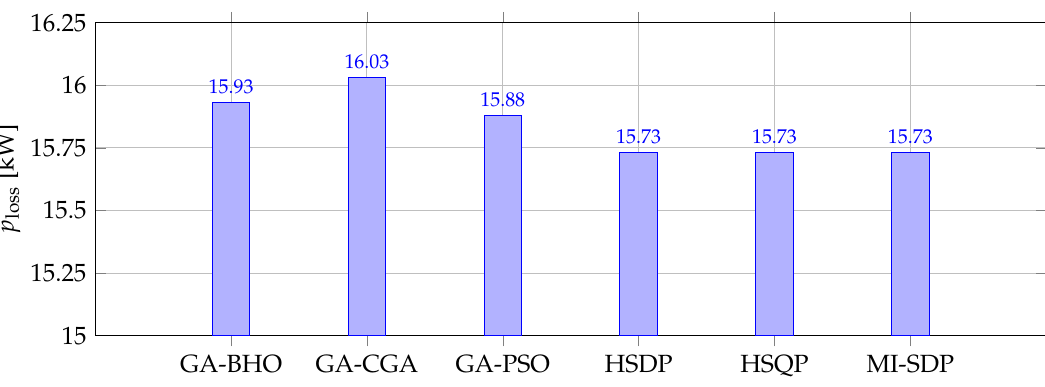
Figure 8. Final power losses when heuristics and metaheuristics are compared to the MI-SDP approach in the 69-node test